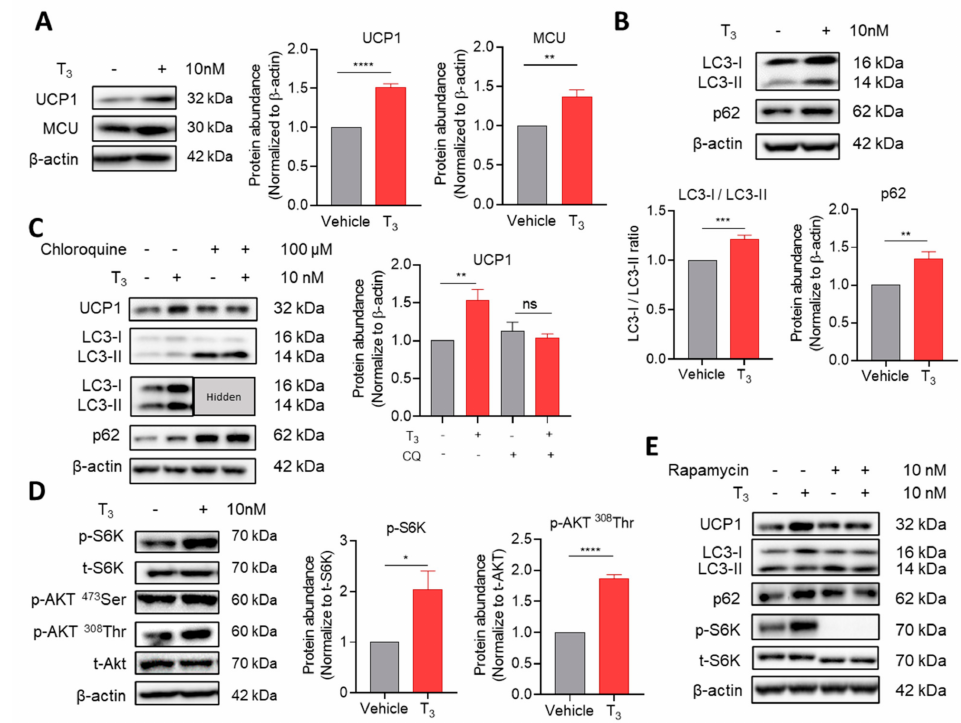
Figure 2. T 3 inhibits autophagic degradation by mTOR activation. ( A ) Western blot and quantitative analysis of UCP1 ( n = 5) and MCU ( n = 4) with 10 nM T 3 treatment for 30 min in immortalized brown adipocytes. ( B ) Western blot of autophagy-related proteins with 10 nM T 3 treatment for 30 min in immortalized brown adipocytes and quantitative analysis of LC3 I/LC3 II ( n = 6), and p62 ( n = 5). ( C ) Western blot of UCP1 and autophagy-related proteins after preincubation with 100 µ M chloroquine for 24 h prior to T 3 treatment and quantitative analysis of UCP1 ( n = 9). ( D ) Western blot and quantitative analysis of mTOR signaling proteins under T 3 treatment ( n = 4). ( E ) Western blot of UCP1, autophagy-related proteins, and S6K under preincubation with 10 nM rapamycin for 1 h prior to T 3 treatment. Data are presented as mean ± SEM. * p ≤ 0.05, ** p ≤ 0.01, *** p < 0.001, **** p < 0.0001, ns not